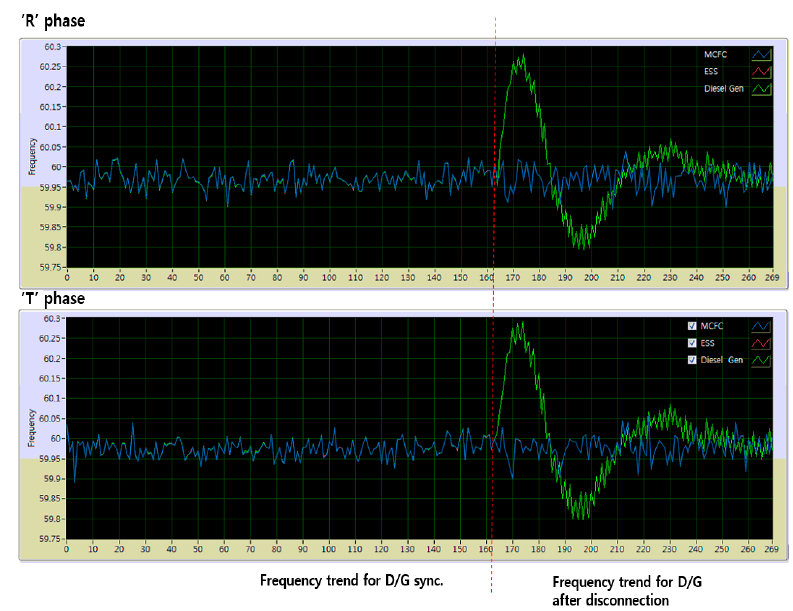
Figure 23. Frequency change when leaving diesel generator system.